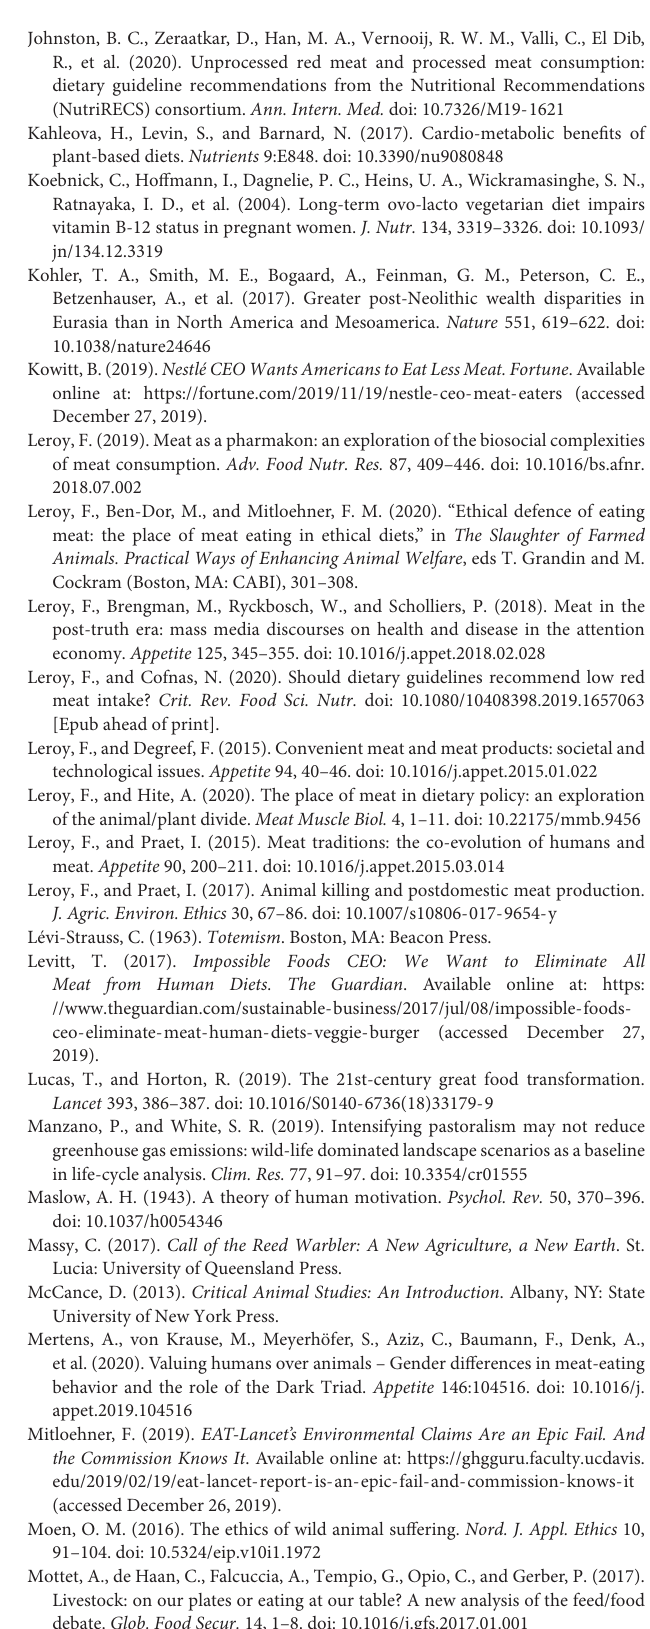
Livestock: on our plates or eating at our table? A new analysis of the feed/food debate. Glob. Food Secur. 14, 1–8. doi: 10.1016/j.gfs.2017.01.001